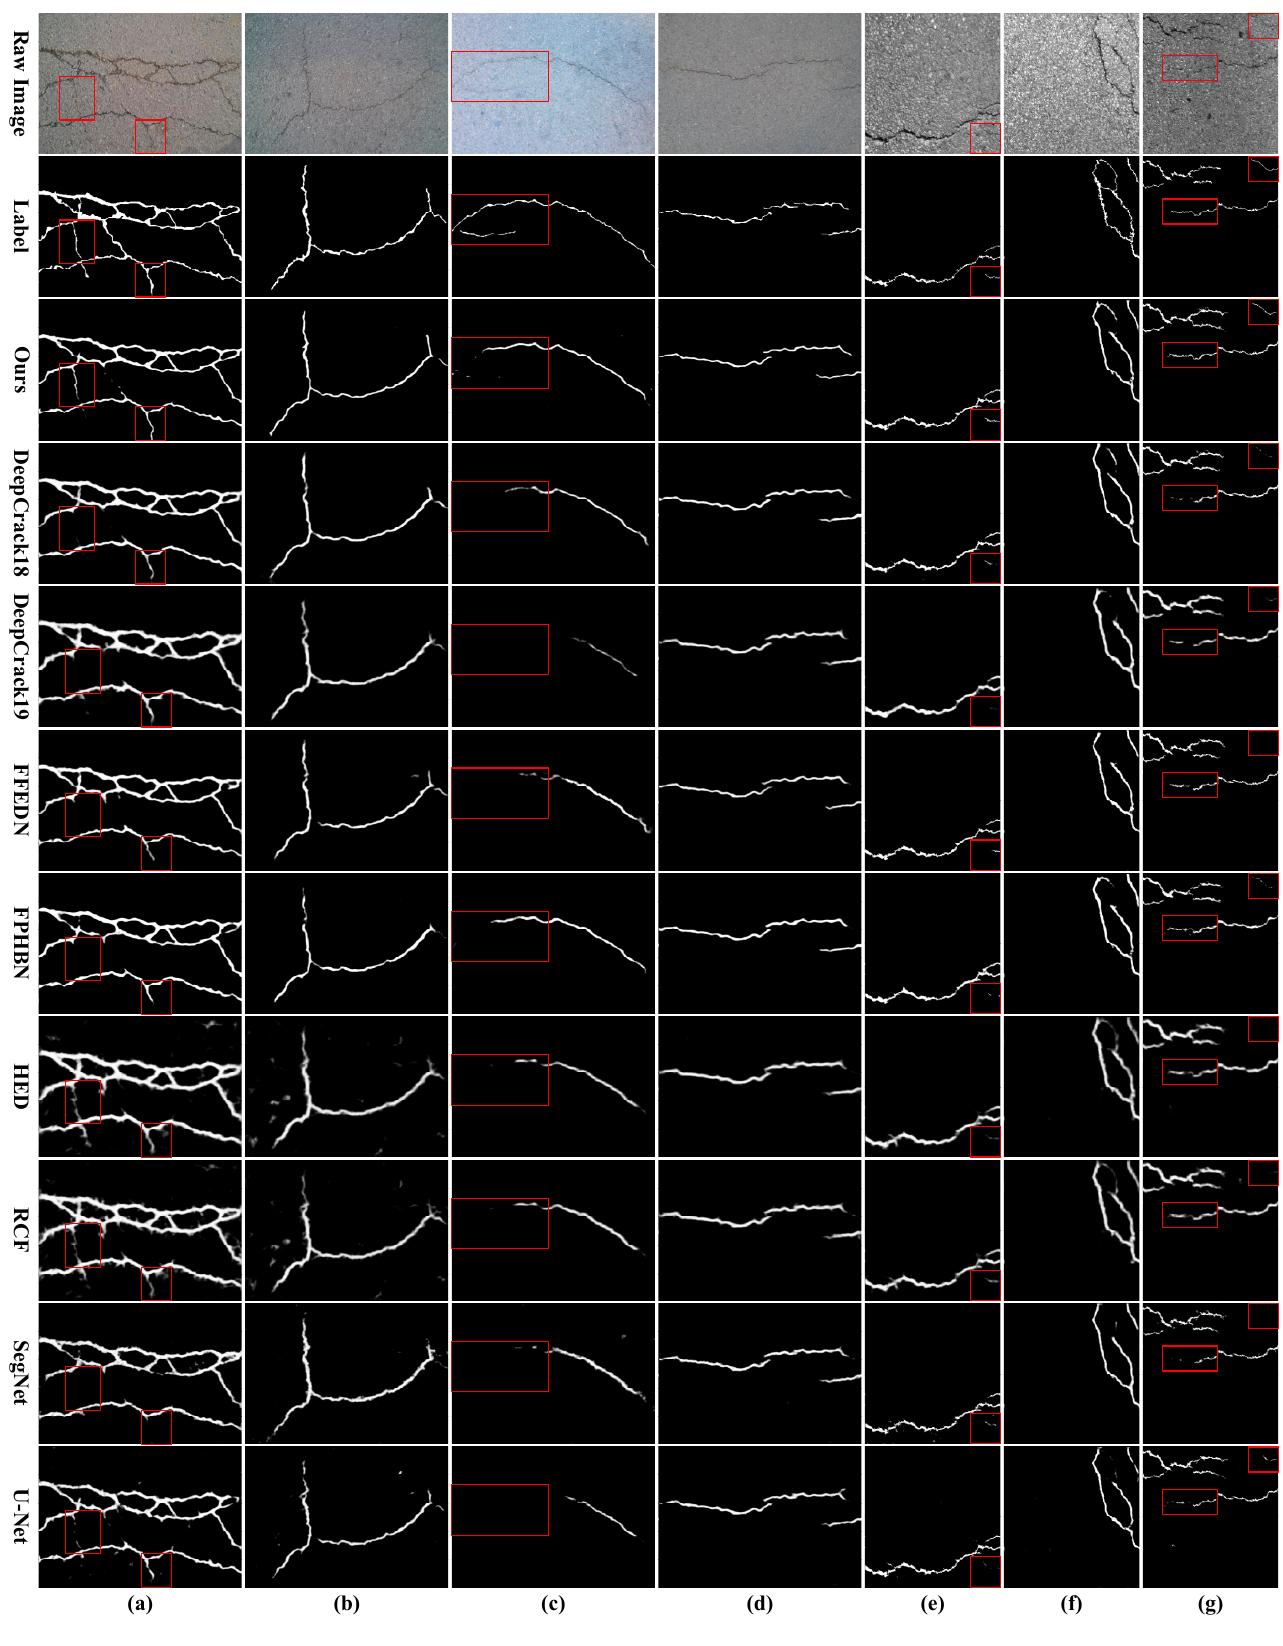
Figure 10. The crack detection results of all methods: ( a – d ) CFD and ( e – g ) AED.